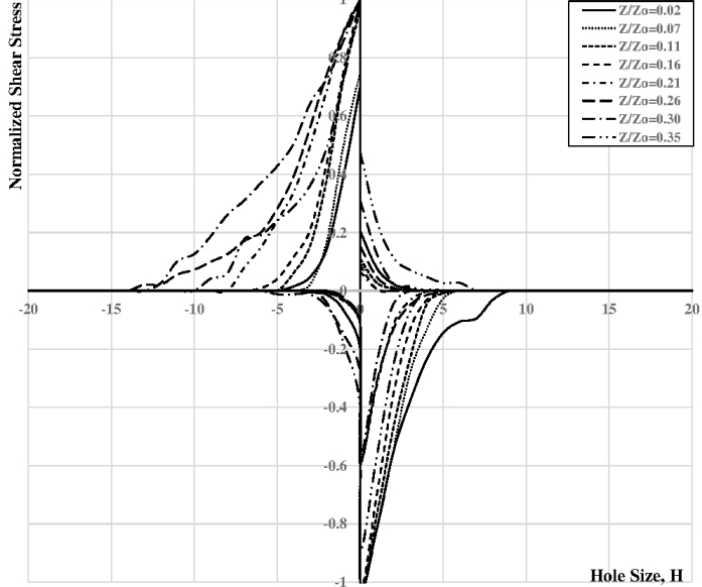
Figure 7. Quadrant analysis of the bursting events close to the weir (x = 2.50 m from origin of the